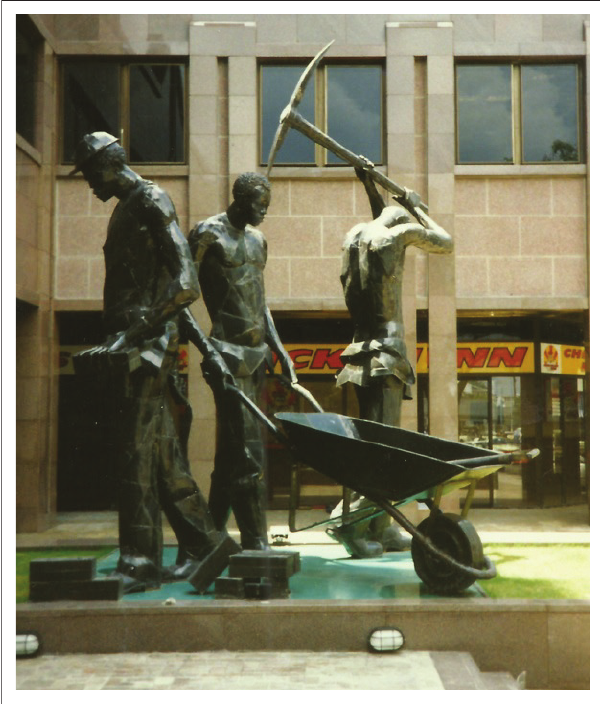
FIGURE 6: Construction workers, Adam